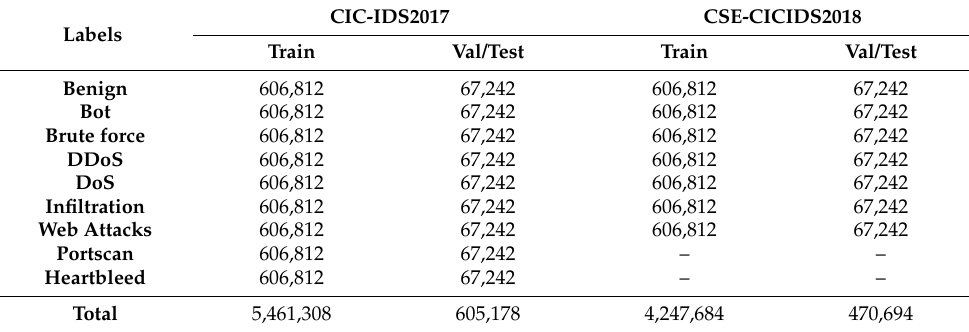
Table 5. Distribution of data for training, validation, and testing of the